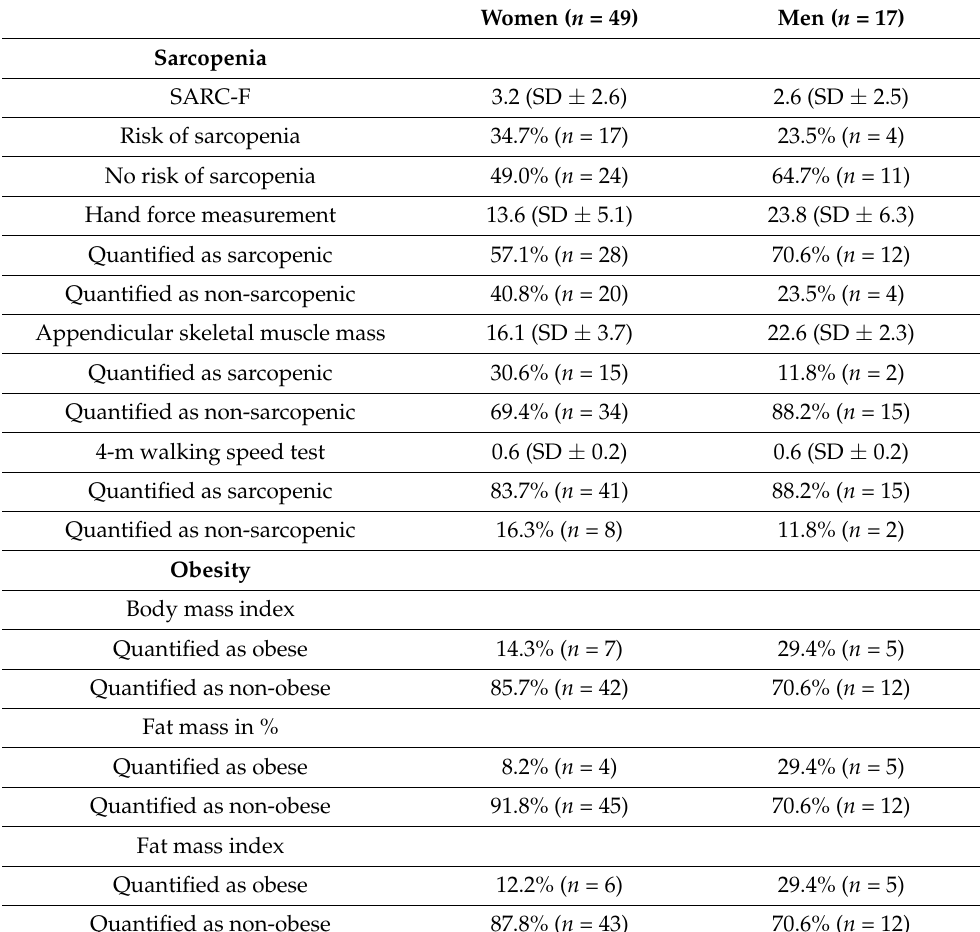
Table 5. Quantification of sarcopenia and obesity in the BaSAlt